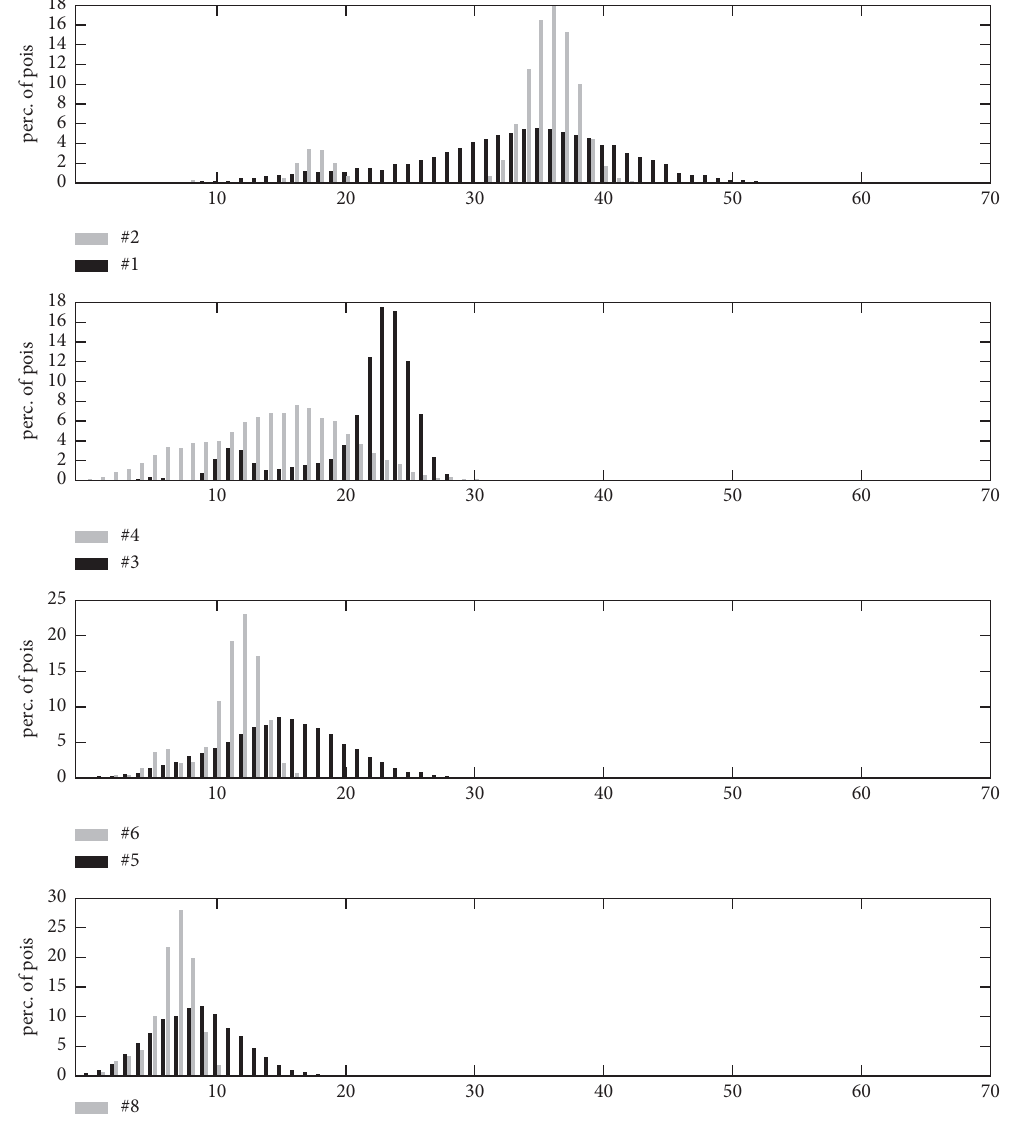
Figure 10: Percentage numbers of POIs covered by diferent numbers of sensors for